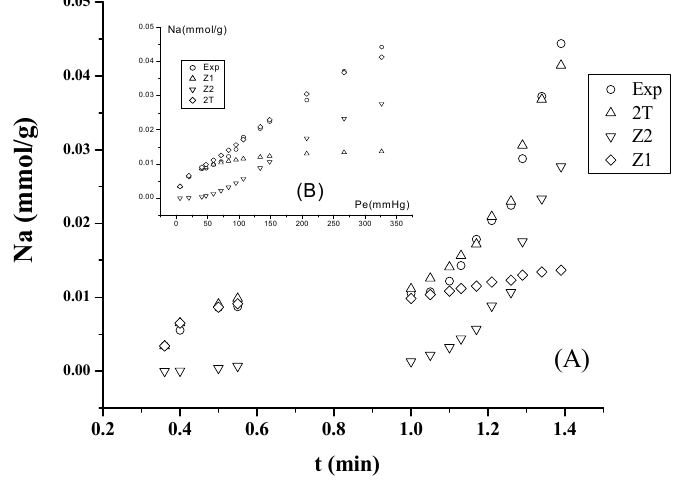
Table 1. Parameter settings of two terms Dubinin equation obtained from nitrogen adsorption isotherm. Zone N m [mmol/g] E c [J/mol] D p [nm]. 1 0.041 2481